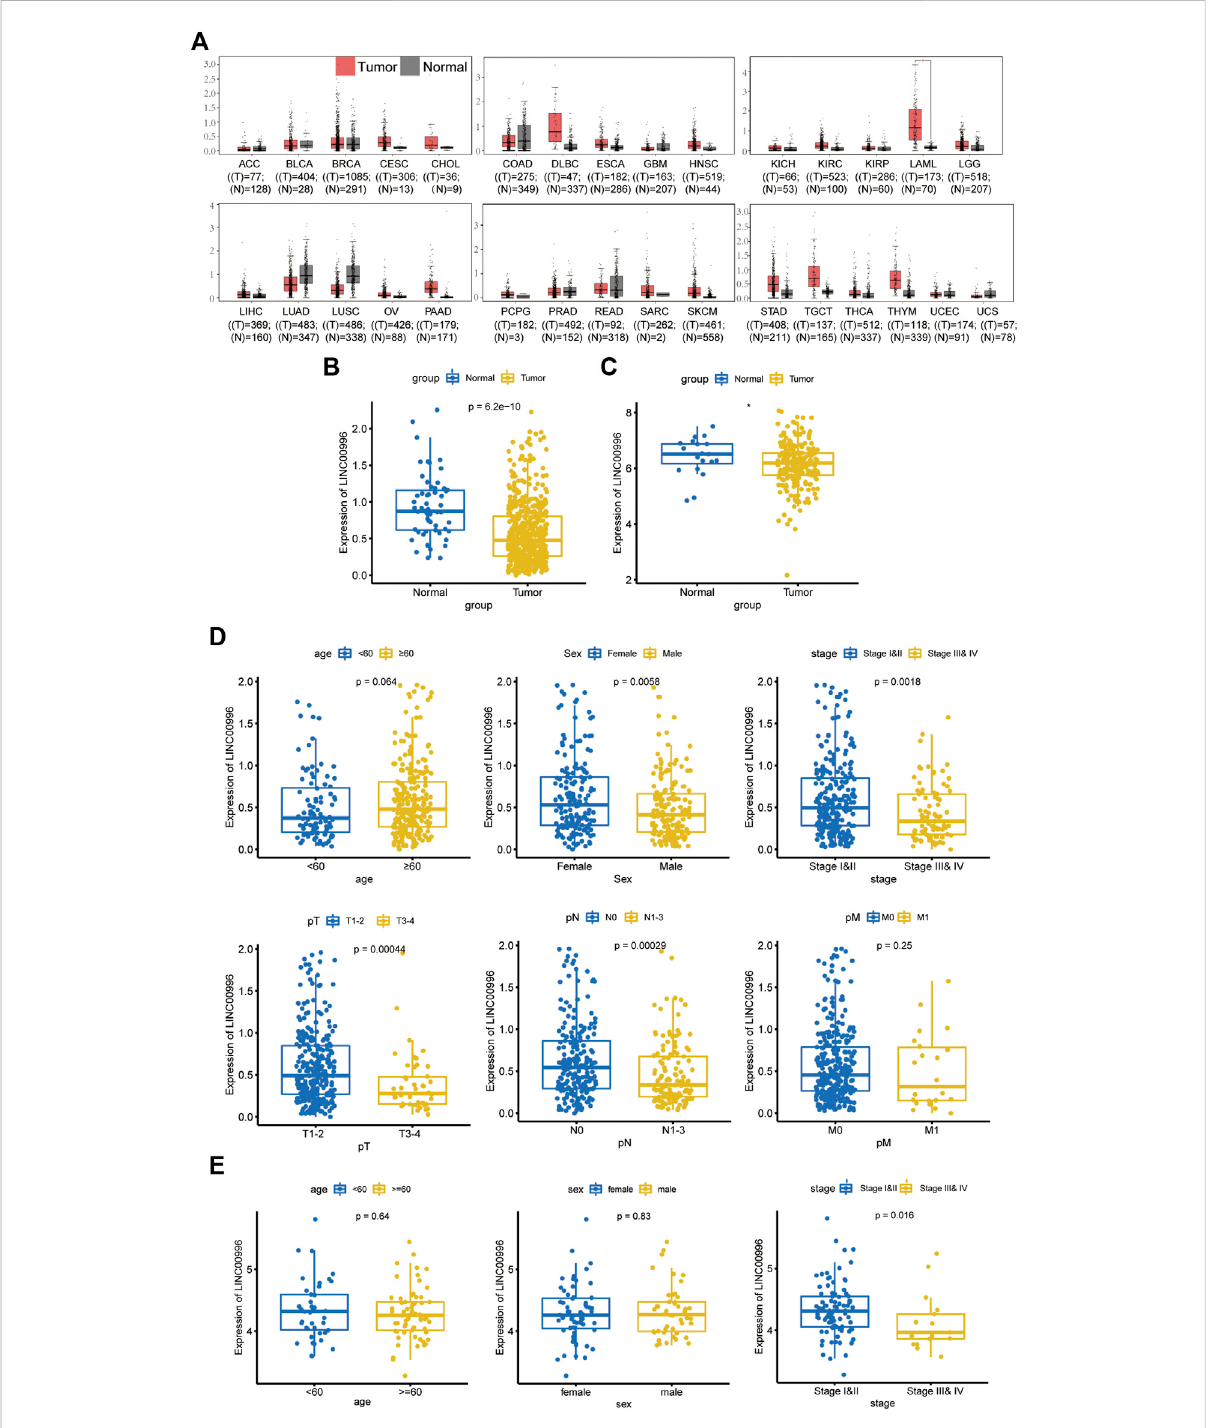
FIGURE 1 (A) GEPIA database analysis of the expression of Linc00996 across cancers. (B) Expression of Linc00996 in TCGA-LUAD. (C) Expression of Linc00996 in LUAD in GSE31210. (D,E) Expression of Linc00996 in TCGA-LUAD and GSE37745 under various clinical